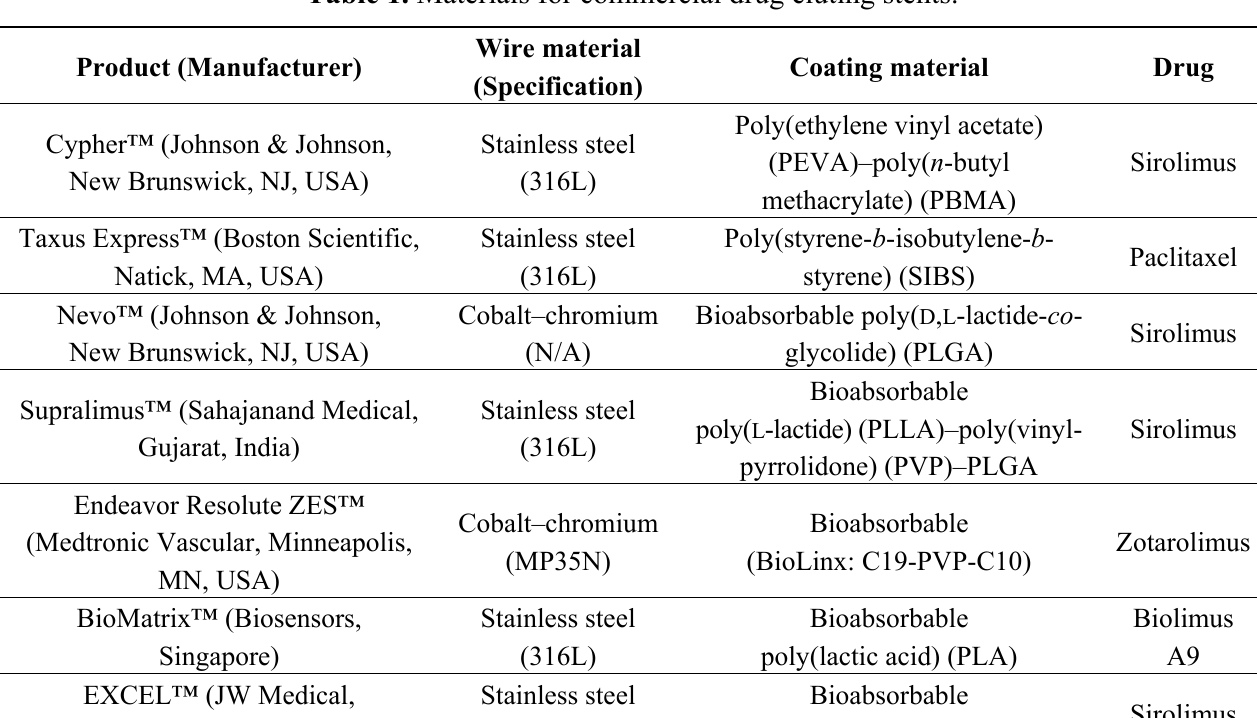
Table 1. Materials for commercial drug eluting